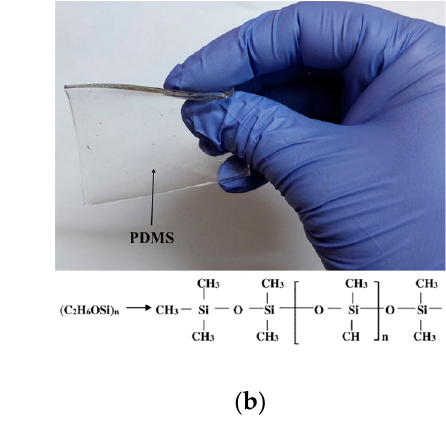
Figure 1. PDMS development process ( a ) and developed PDMS ( b